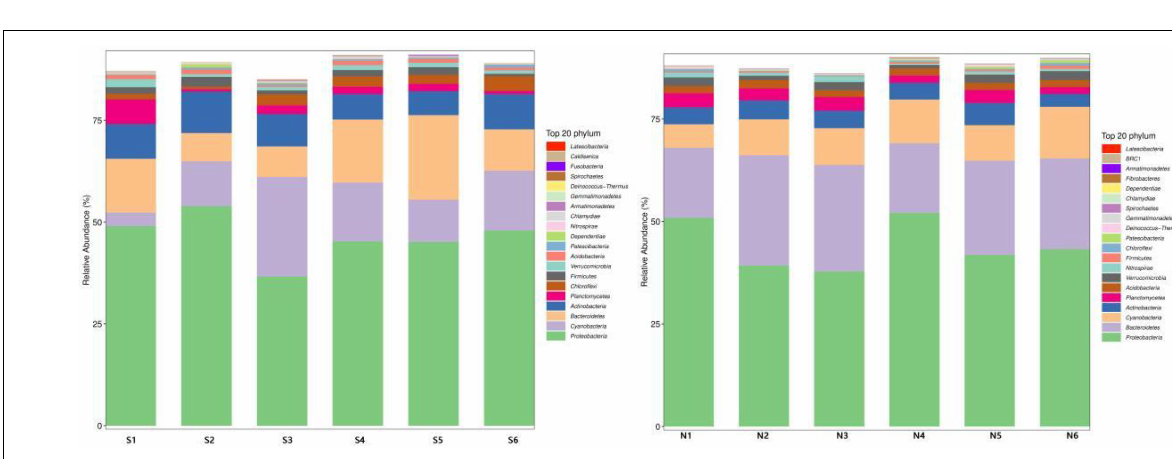
FIGURE 5 | Changes in microbial communities at the phylum level in the sediments of South (S) and North Taihu Lake (N).